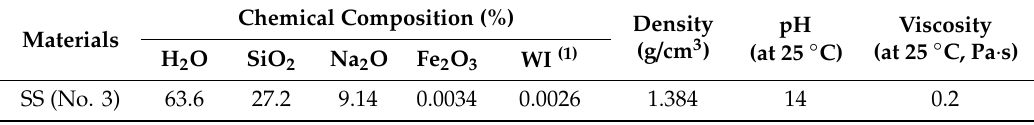
Table 1. Chemical composition and physical properties of used chemical liquids. SS, sodium silicate.